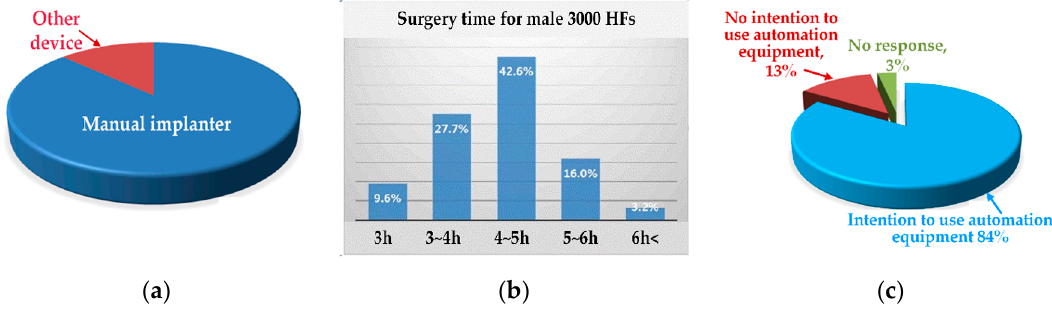
Figure 3. Survey on development of automated hair implanter; ( a ) hair transplantation method, ( b ) surgery time, and ( c ) willingness to use automated equipment.